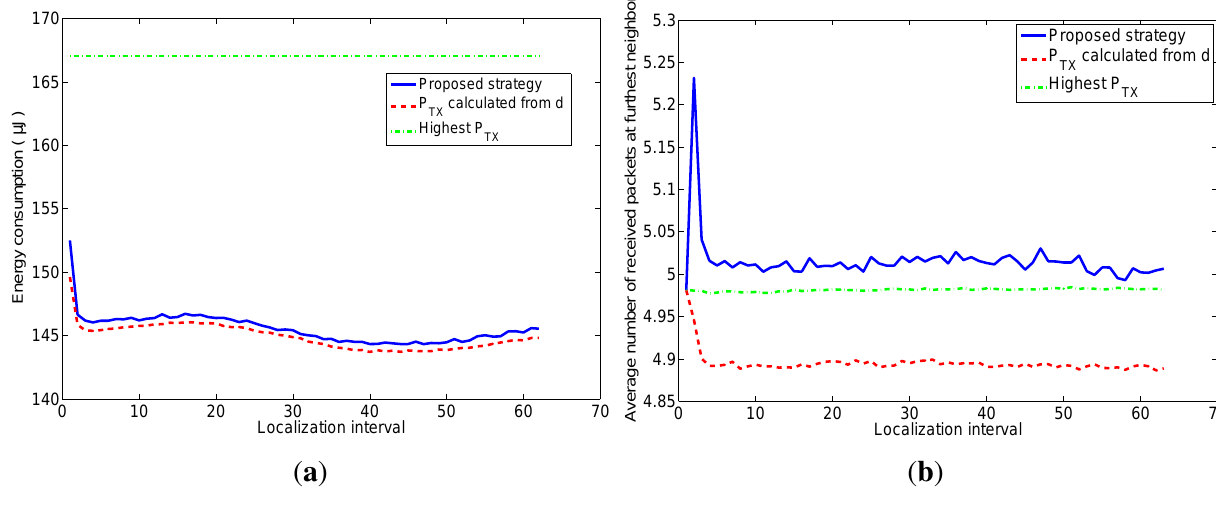
Figure 12. Average energy consumption and average number of received packets at the furthest node of the three strategies for the CC2420 consumption model.